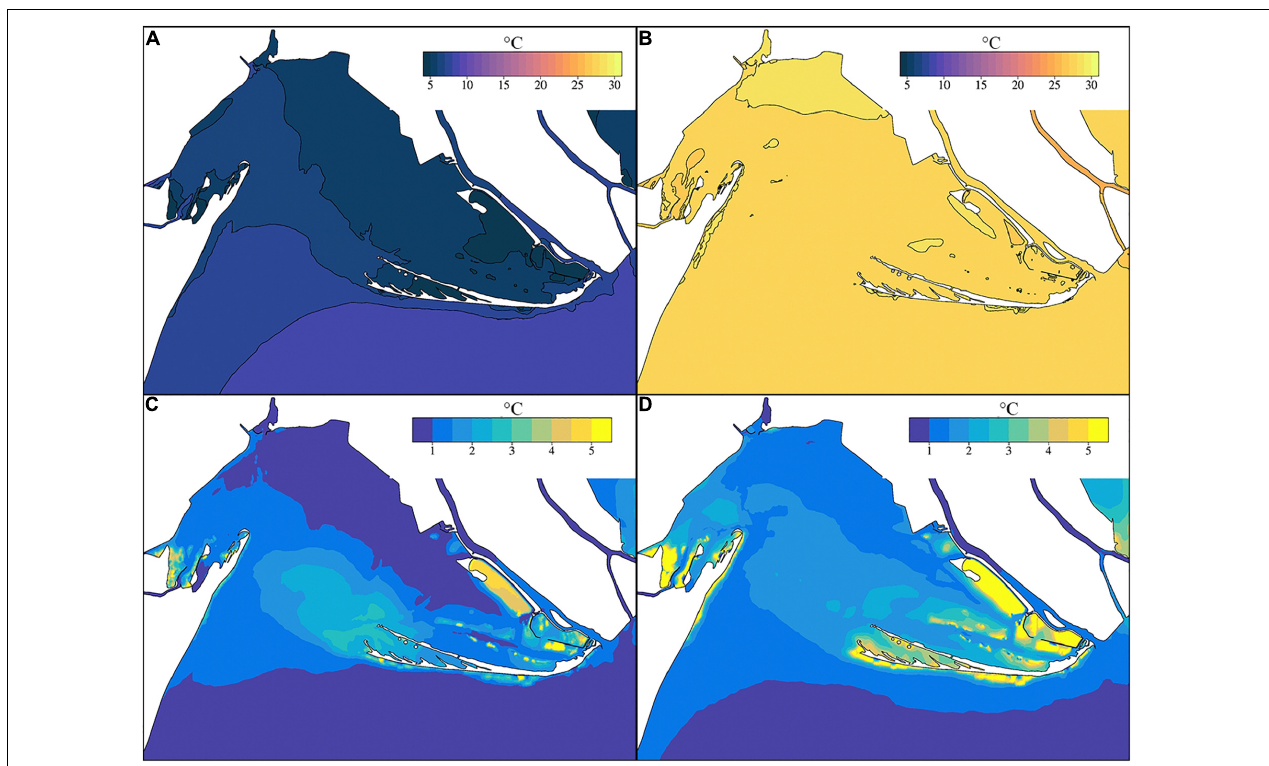
FIGURE 10 | Average temperature of the water column in February (A) , August (B) and average daily range (daily maximum – daily minimum) in February (C) , August (D) 2018.